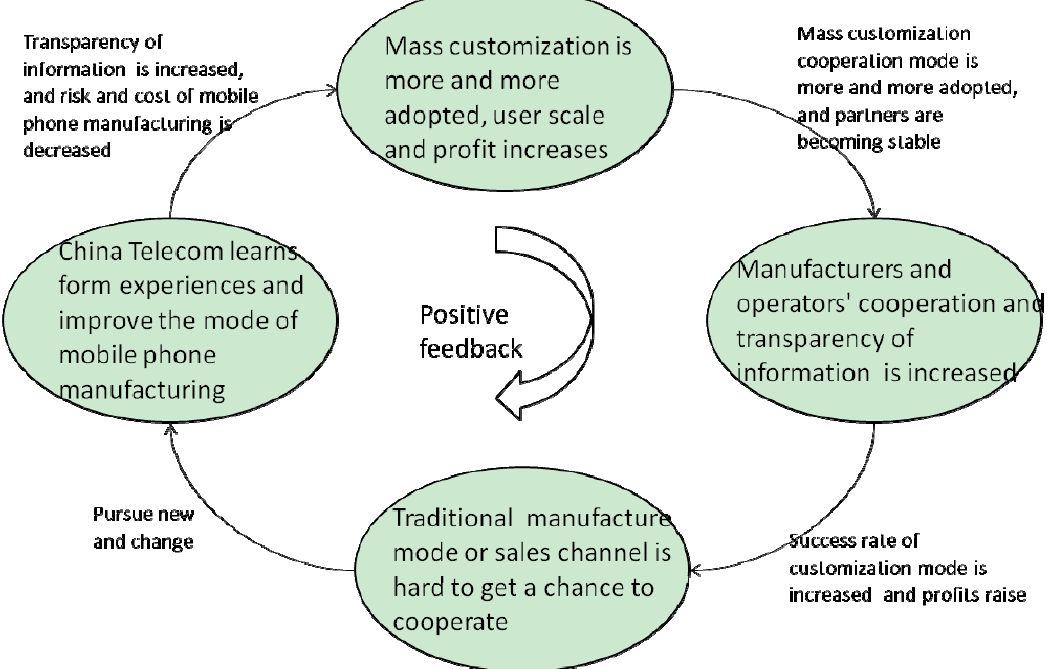
Figure 5. Flow chart of mobile phone customization cooperation pattern of China